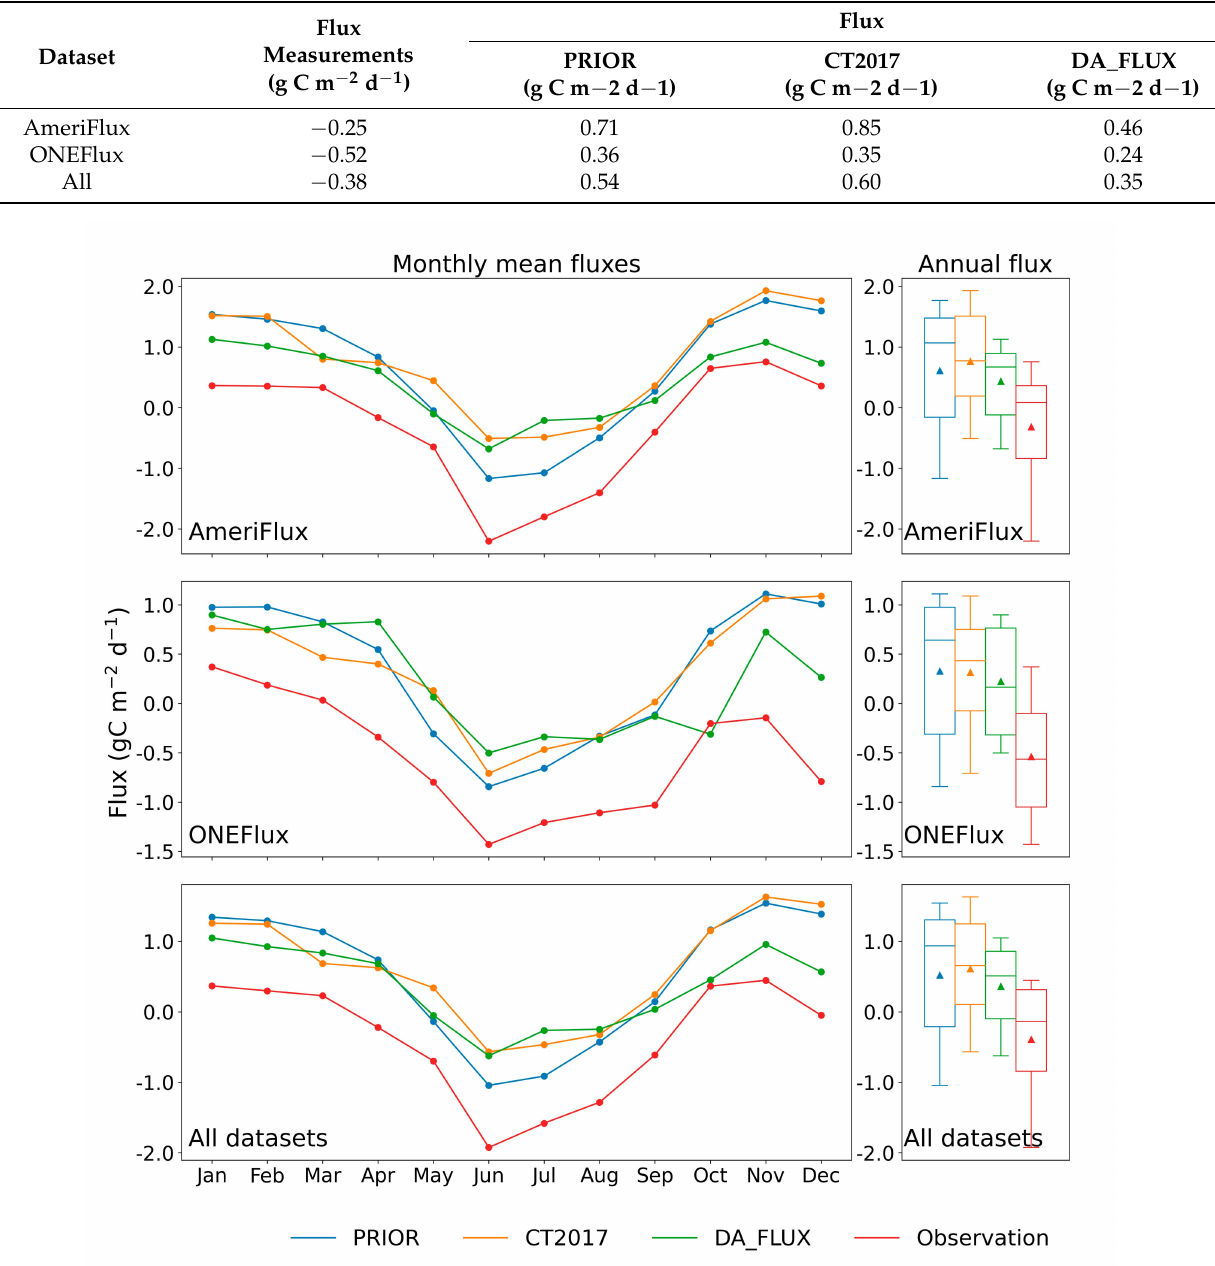
Figure 8. Monthly and annual mean of the prior (PRIOR), posterior (DA_FLUX) CO 2 flux of the DA_FLUX experiment, the posterior CO 2 flux of CT2017, and the CO 2 flux measurements from AmeriFlux and ONEFlux. For the boxplots on the right, the lower and upper edges of the boxes represent the first (Q1) and third (Q3) quartiles, the lower and upper whiskers represent the minimum and maximum values within 1.5 times the interquartile range from Q1 and Q3, respectively, solid lines and triangles represent median and mean